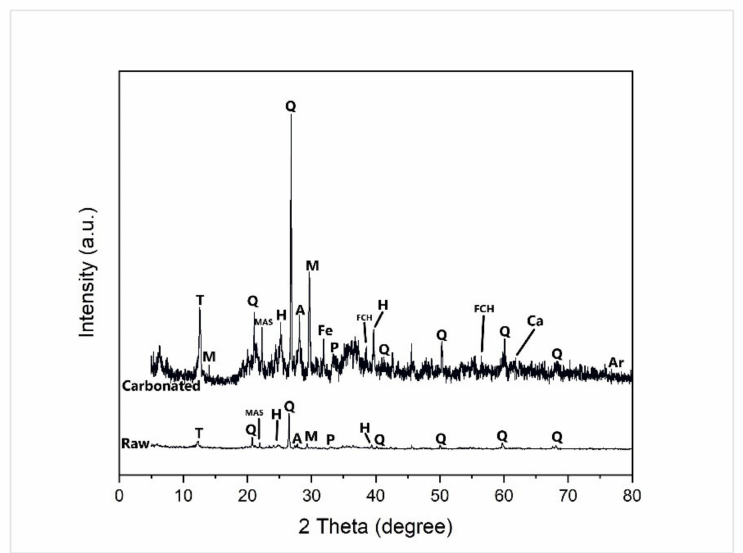
Figure 12. X-ray diffractogram patterns of raw and carbonated samples of Fe-rich mine waste. Labelled alphabet represents the minerals found in the waste: quartz (Q), anorthite (A), wollastonite (W), diopside (D), titanium Silicon (T), magnetite (M), perovskite (P), magnesium aluminium silicate (MAS), johannsenite (J), hematite (H), aragonite (Ar), siderite (Fe), iron carbonate hydroxide (FCH) and calcite